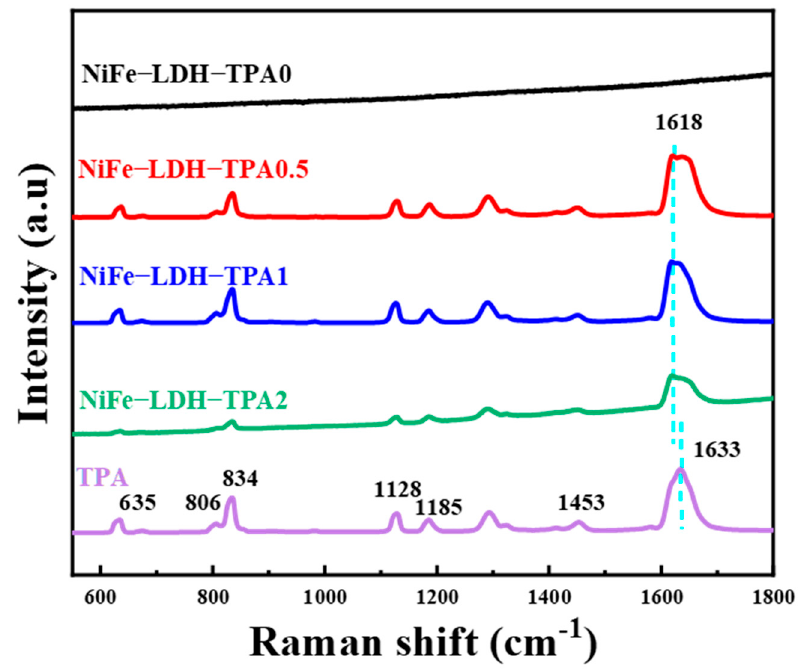
Figure 5. Raman spectra of NiFe-LDH-TPA0, NiFe-LDH-TPA0.5, NiFe-LDH-TPA1, NiFe-LDH-TPA2, and TPA as a reference.